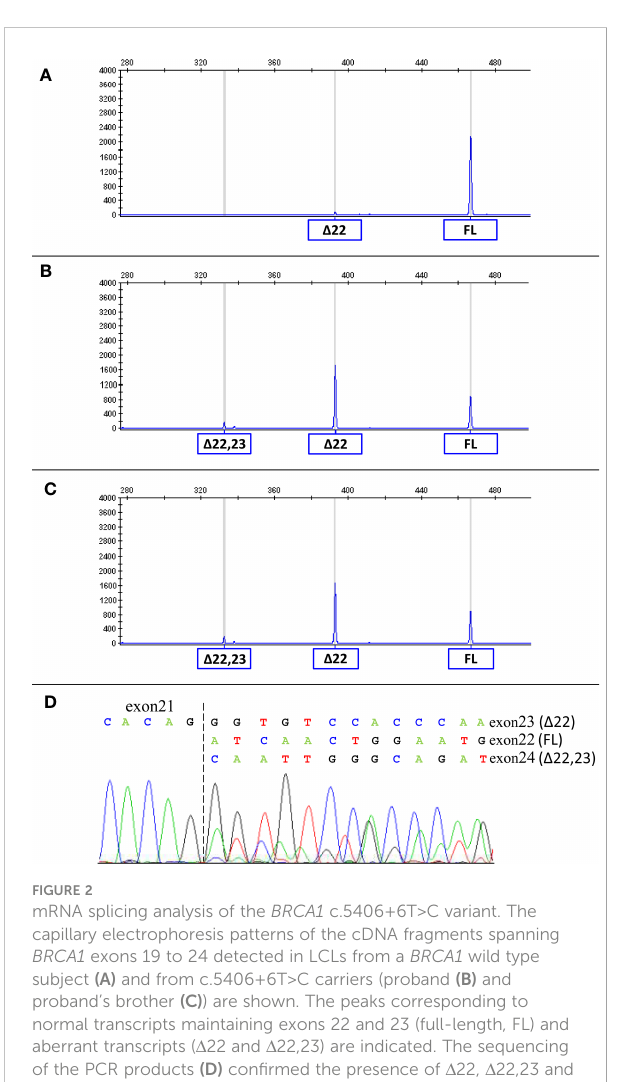
FIGURE 2 mRNA splicing analysis of the BRCA1 c.5406+6T>C variant. The capillary electrophoresis patterns of the cDNA fragments spanning BRCA1 exons 19 to 24 detected in LCLs from a BRCA1 wild type subject (A) and from c.5406+6T>C carriers (proband (B) and proband ’ s brother (C) ) are shown. The peaks corresponding to normal transcripts maintaining exons 22 and 23 (full-length, FL) and aberrant transcripts ( D 22 and D 22,23) are indicated. The sequencing of the PCR products (D) con fi rmed the presence of D 22, D 22,23 and normal transcripts in carriers of the BRCA1 c.5406+6T>C variant.